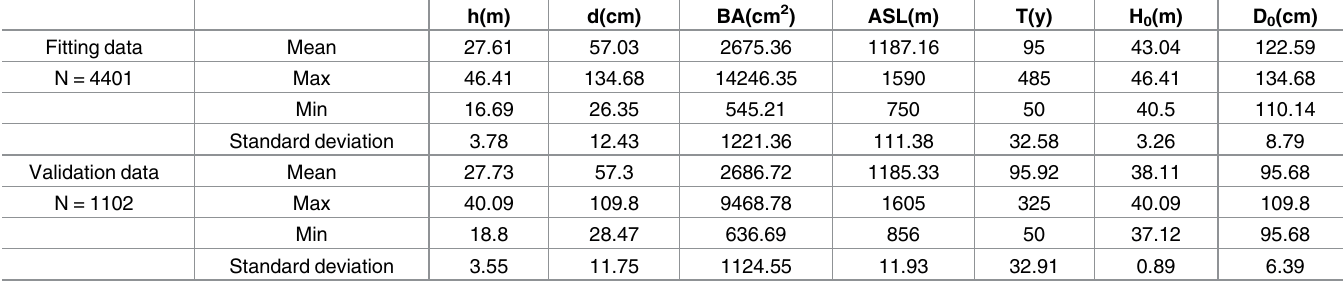
Table 1. Regional Metasequoia sample